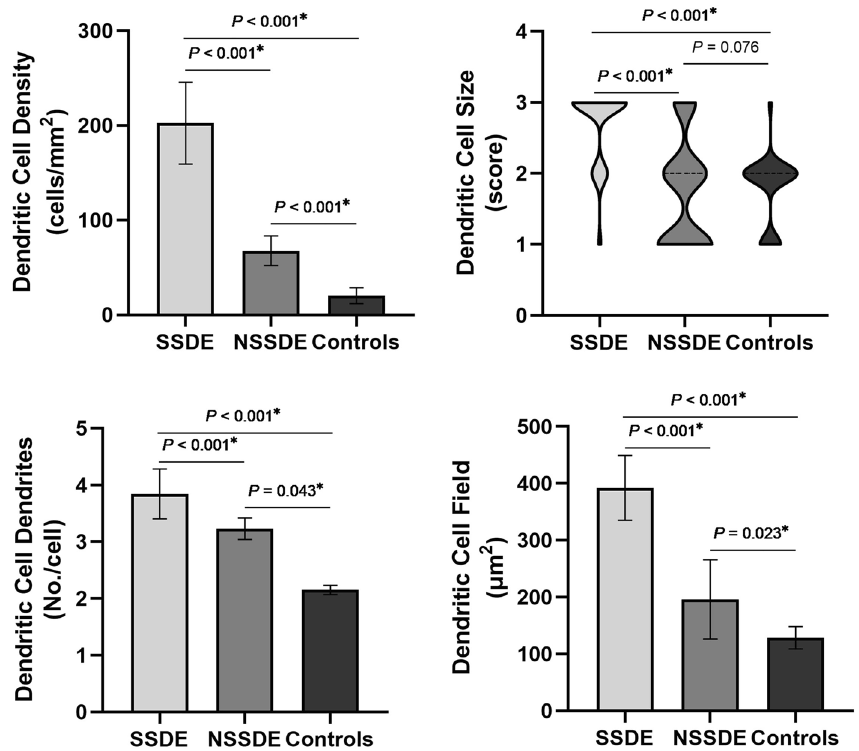
Figure 1. Dendritic cell density and morphologic parameters in SSDE, NSSDE and healthy controls. Compared with NSSDE patients and healthy controls, Dendritic cell density and all morphologic parameters were significantly higher in SSDE group. Dendritic cell density and morphologic parameters, except for dendritic cell size, were significantly higher in NSSDE as compared with the controls. SSDE Sjogren’s syndrome dry eye, NSSDE non-Sjogren’s syndrome dry